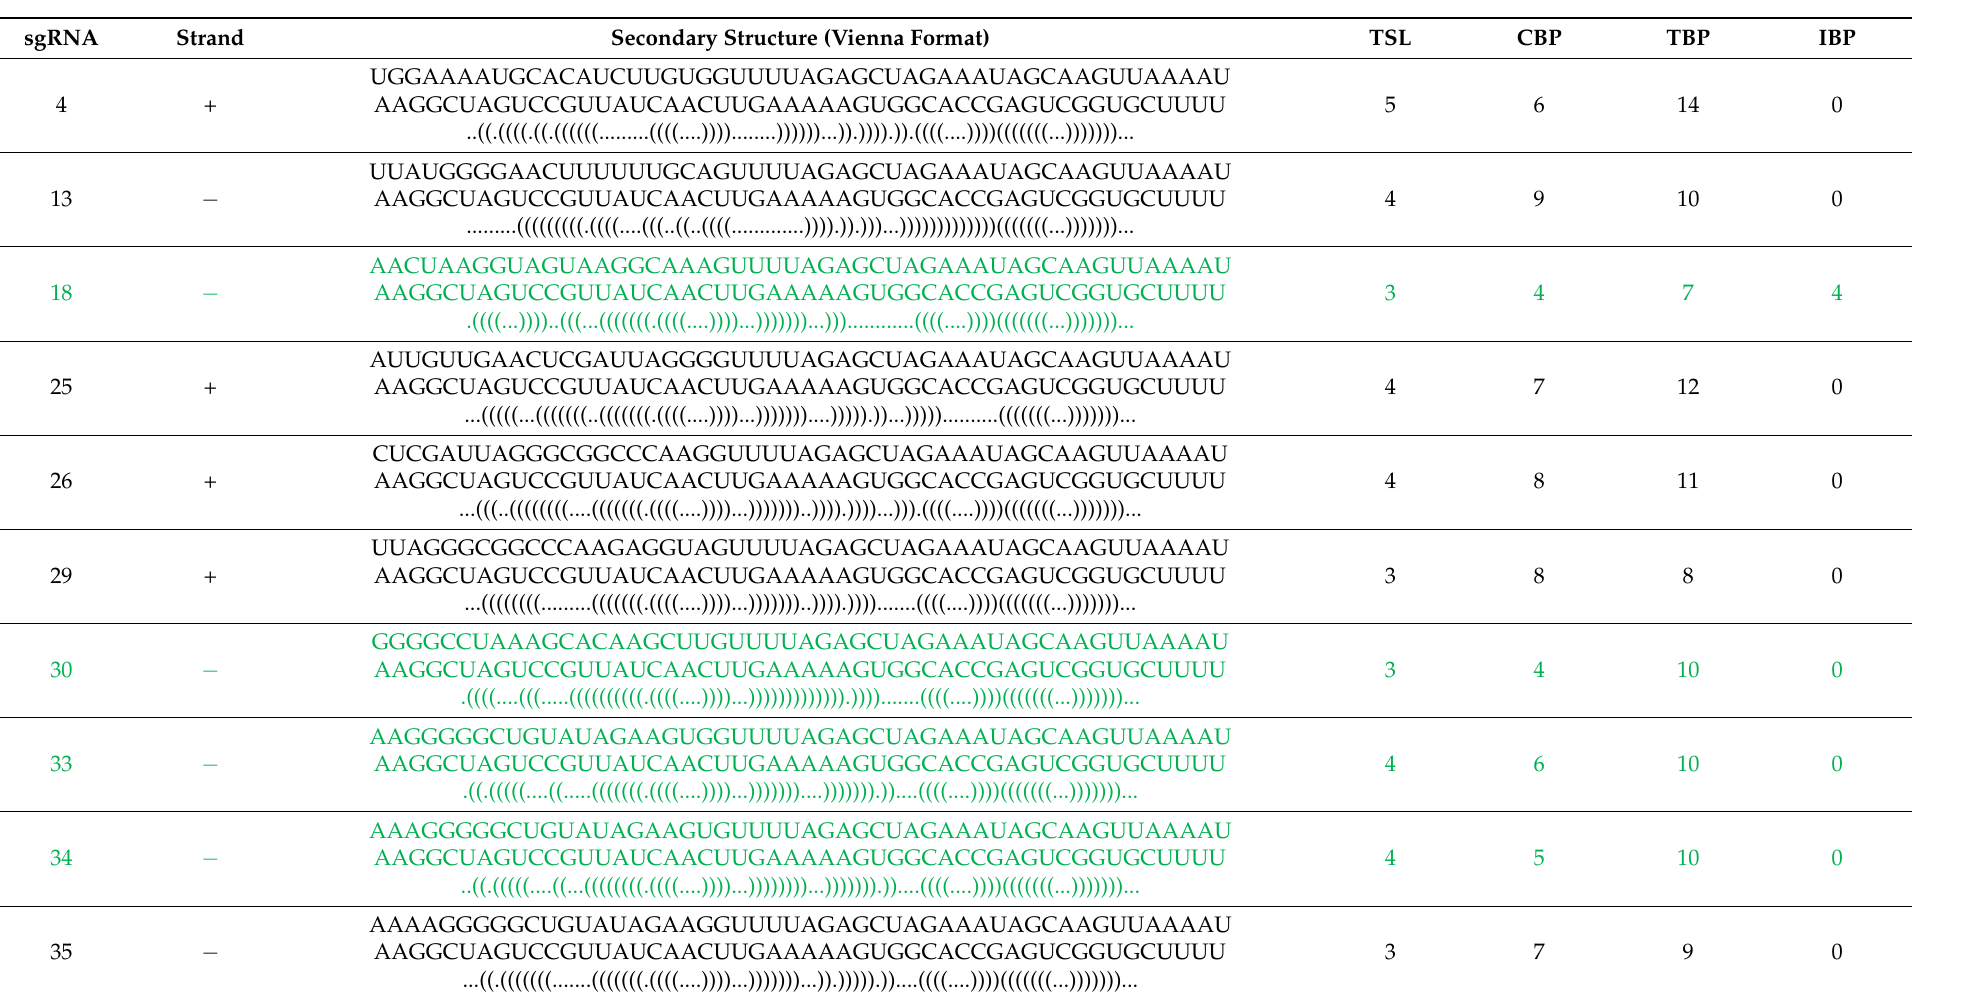
Table 1. Designed sgRNAs targetingthe UGT76G1 gene. RNAfold web server was used in determining the secondary structure and other features (loops and base